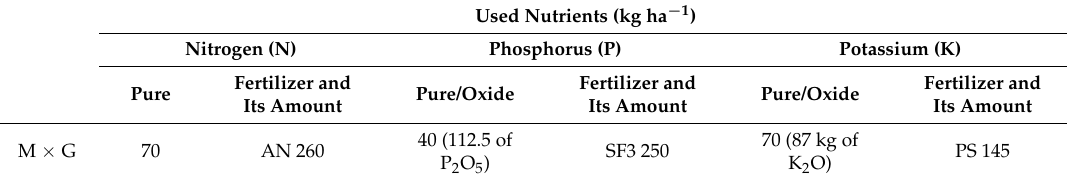
Table 6. Methodology of fertilization of Miscanthus × Giganteus applied in productive years.